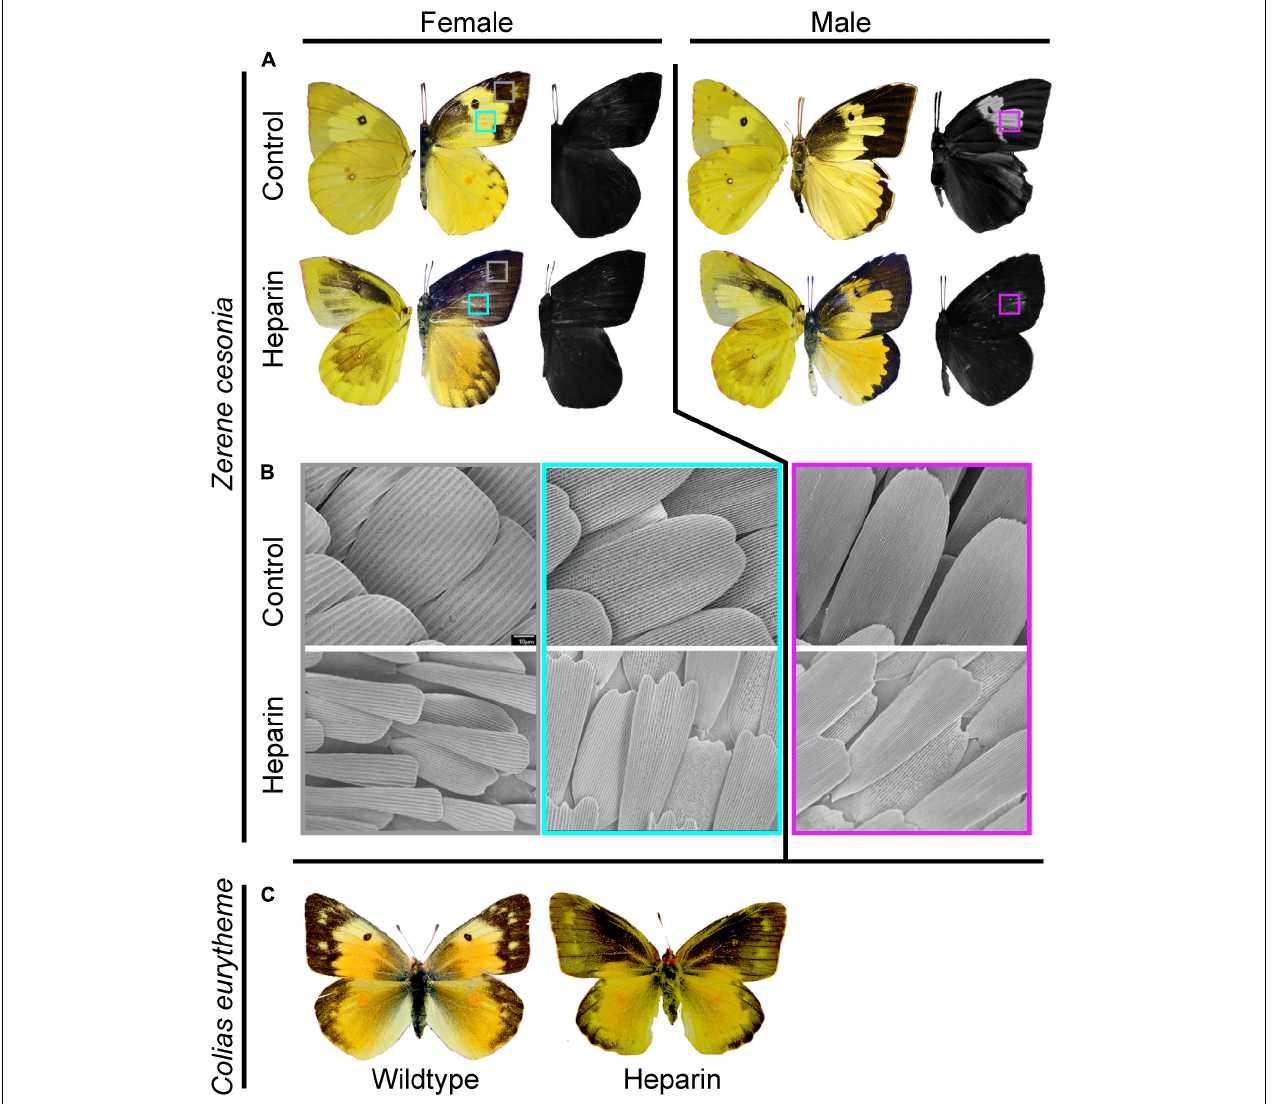
FIGURE 3 | Heparin impacts pigment and structurally based colors on Z. cesonia wings. (A) Heparin treated female Z. cesonia showed an increase in melanization across wings and Heparin treated males lost UV reflectance. Left side wings show ventral side and right side wings show dorsal. (B) SEM imaging (1000X) of scales from control and Heparin treated wings shows difference in scale morphology and organization. (C) Female C. eurytheme dorsal wings showed melanic expansions with Heparin